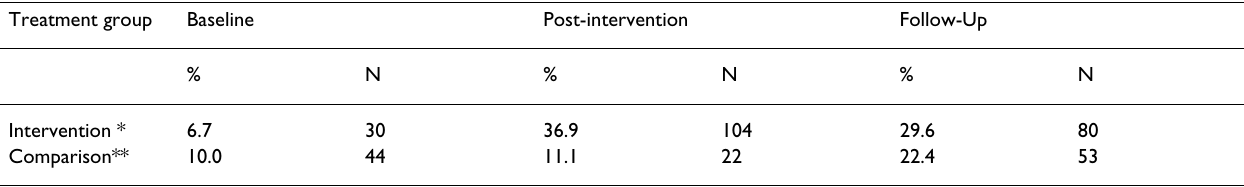
Table 1: Percentage distribution of women asked about their reproductive intentions Treatment group Baseline Post-intervention